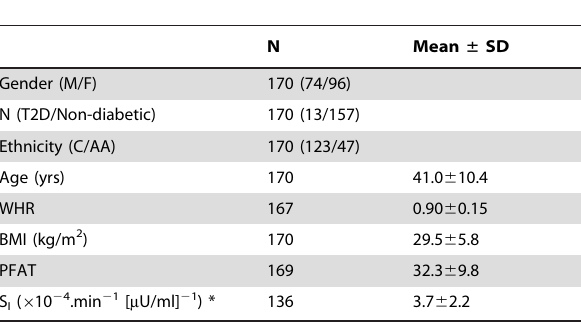
Table 1. Characteristics of study